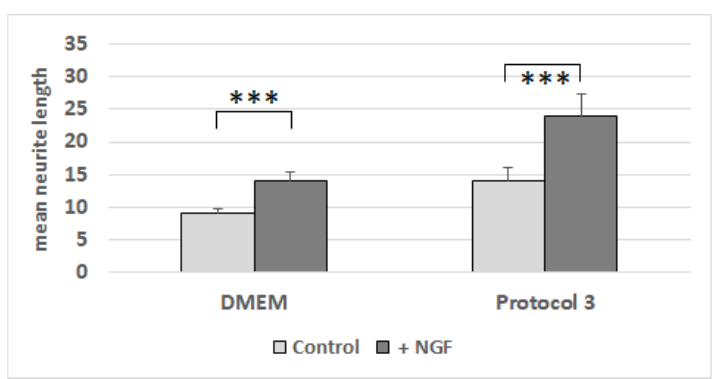
Figure 10. Lengths of neurites in µm on NG108-15 cells after cultivation with DMDM or Protocol-3 medium, with and without NGF supplementation. The mean value and standard error of the mean for each condition are shown. ***: p -value < 0.001.